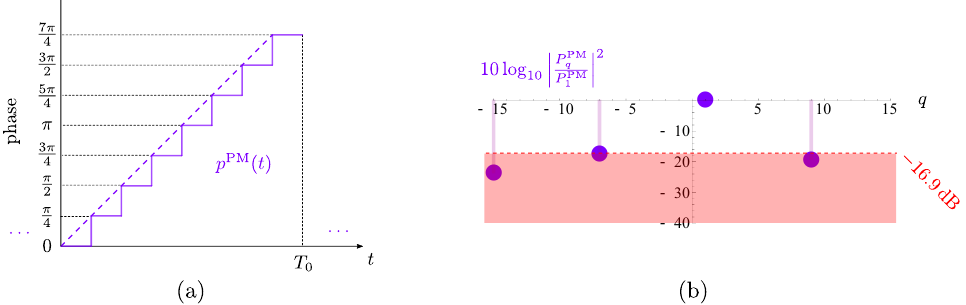
Figure 3. ( a ) Discretized linear-phase PM waveform (one period) with 8 levels. ( b ) Normalized Fourier series power spectrum of the discretized waveform.